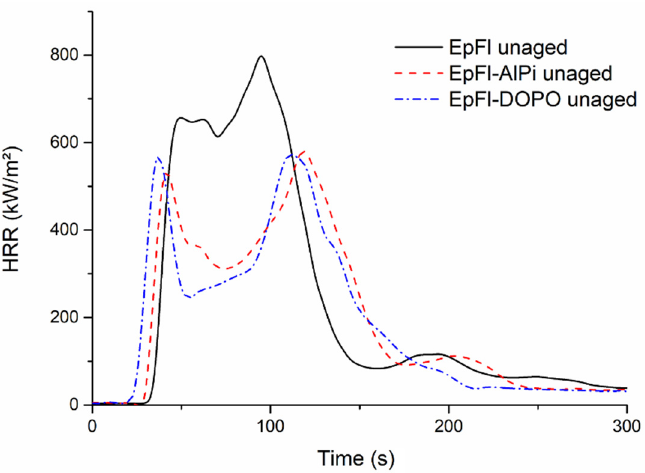
Figure 12. Cone calorimeter curves of unaged biocomposites.